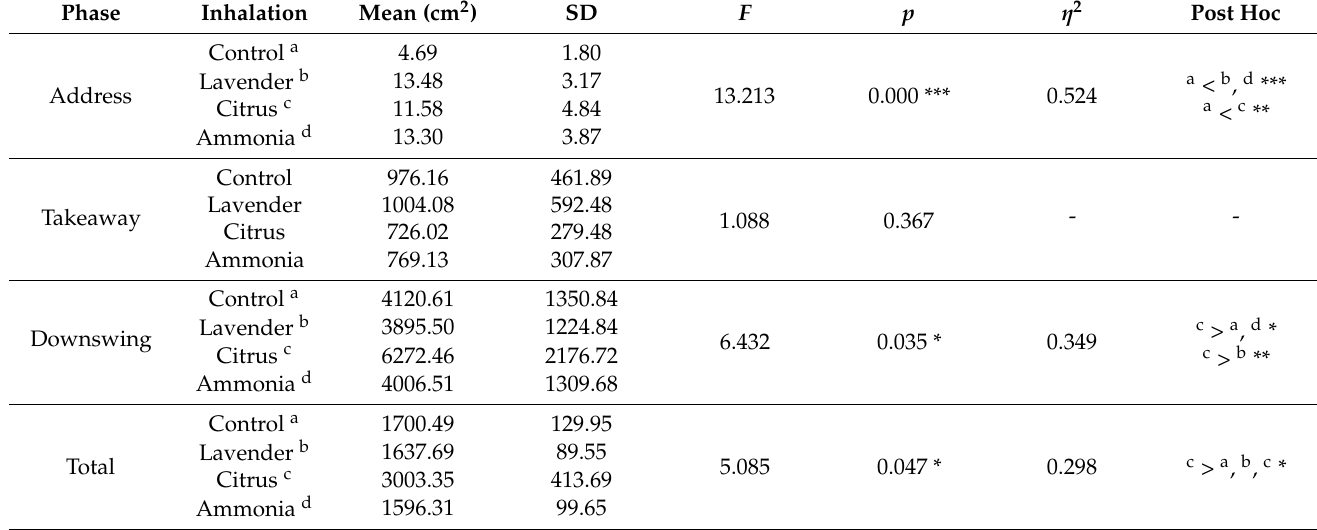
Table 3. CoP area according to olfactory inhalation ( n =